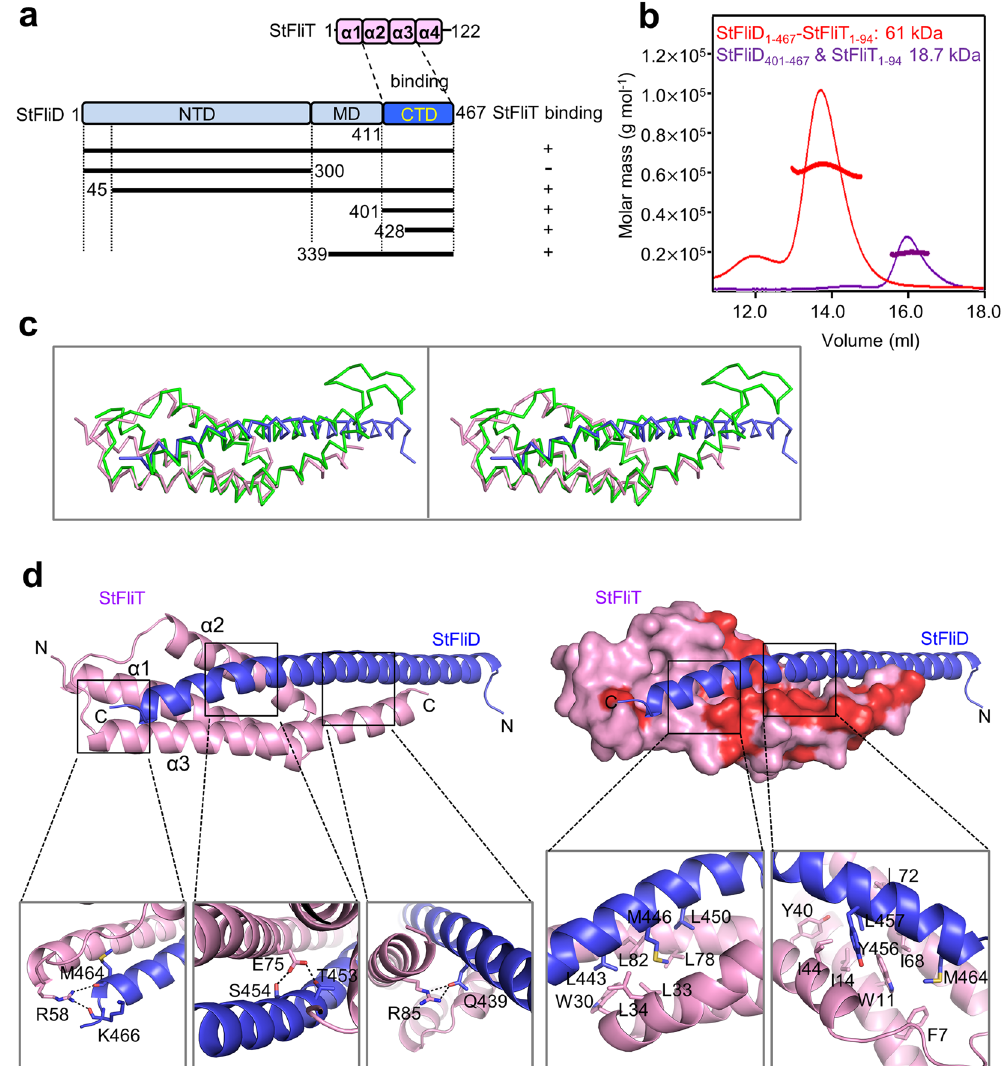
Figure 1. Crystal structure of StFliD-StFliT complex. ( a ) Domain architectures of StFliD and StFliT. ( b ) The StFliD 1–467 -StFliT 1–94 and StFliD 401–467 -StFliT 1–94 complexes were analyzed by SEC-MALS. The thick line represents the measured MW. ( c ) Stereo figure superposing crystal and solution structures of StFliD-StFliT complex (PDB codes 5GNA and 5KRW, respectively). Crystal structures of StFliD and StFliT were colored in pink and light blue, respectively, and solution structure of StFliD-StFliT complex was colored in green. ( d ) Ribbon and surface diagrams of the StFliD 401–467 -StFliT 1–94 complex. Magnified views showing detailed interactions at the StFliD-StFliT interfaces are shown and sequence conservation was mapped on the surface of StFliT in red